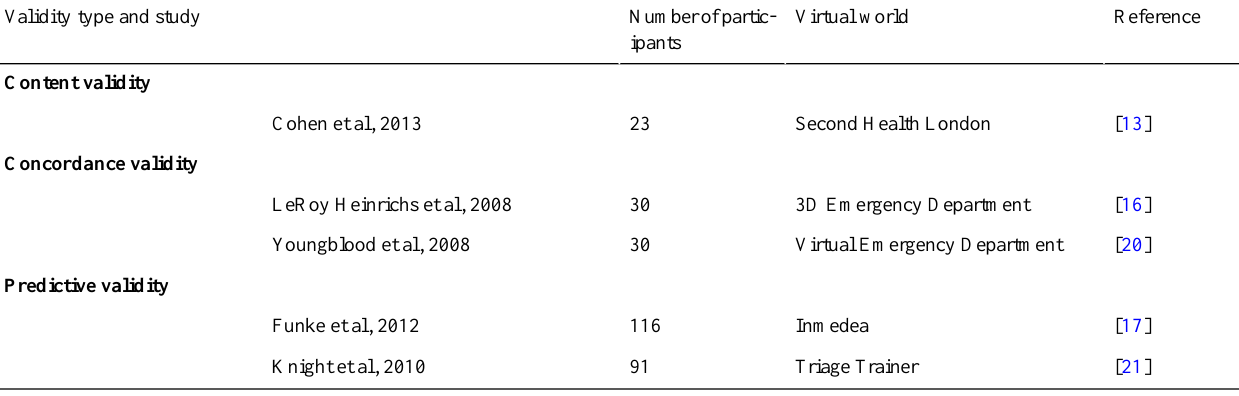
Table 2. Overview of the validity level of all currently available virtual patient